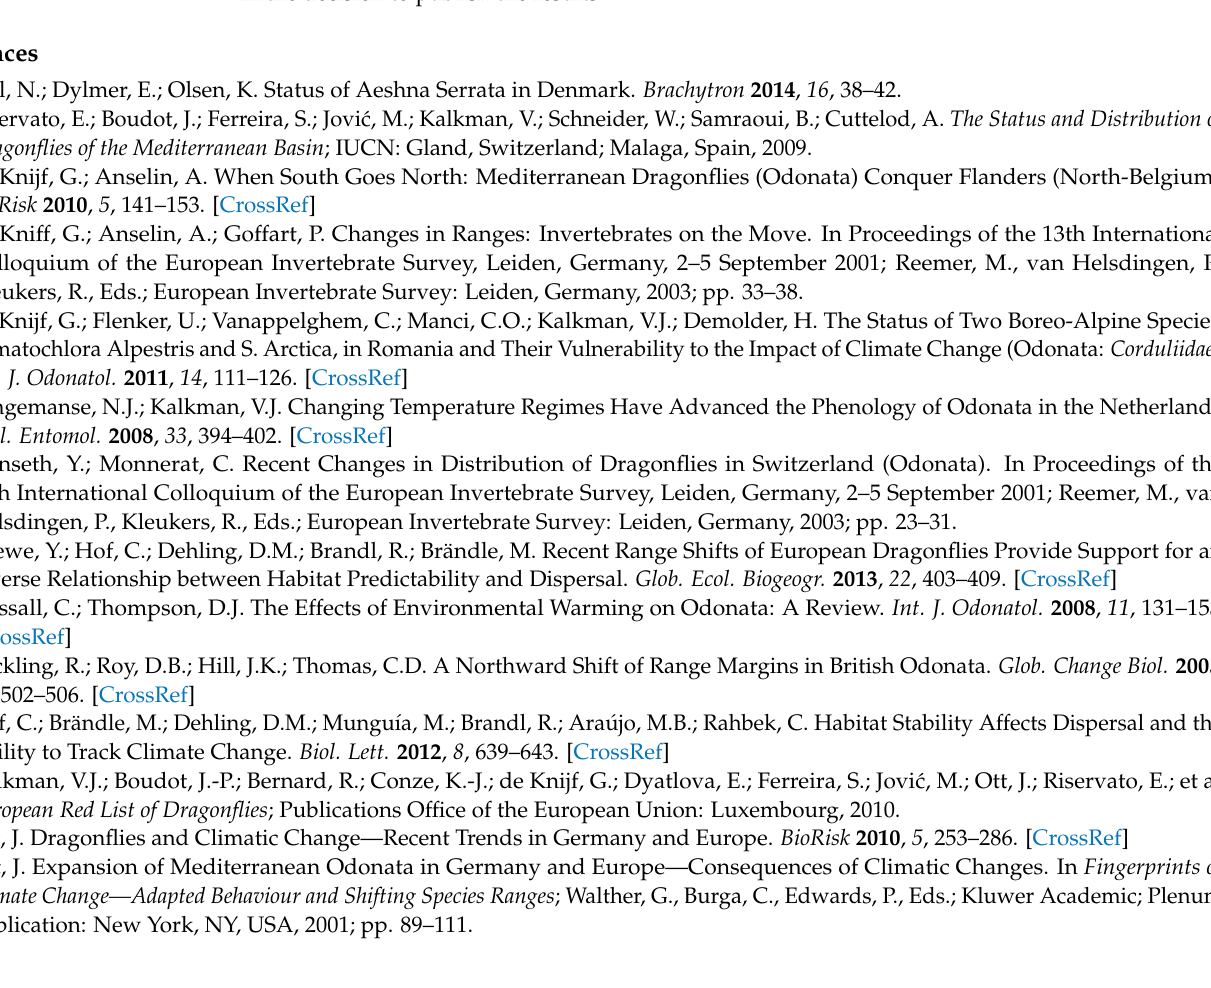
in this table; Table S3: Different measures of range size and test results by ecological habitat category; Table S4: Different measures of range shift and test results for all species and range contracting species by ecological habitat